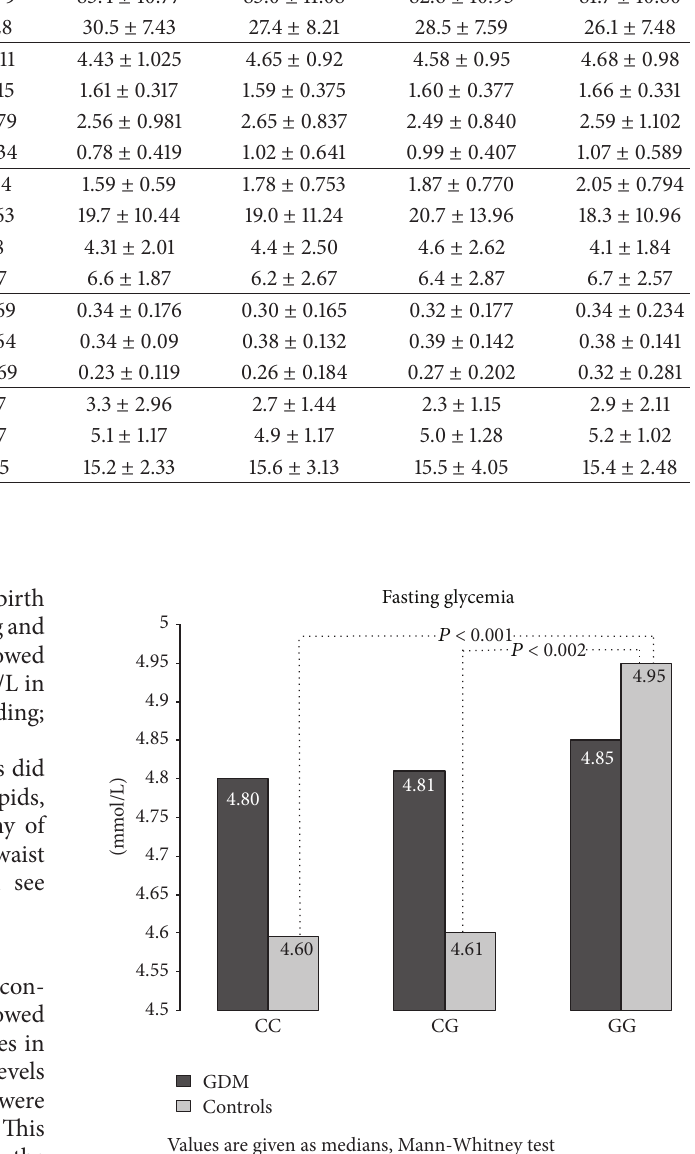
69.2 ± 17.72 , resp.; 𝑃 = 0.02 ), as well as HOMAF index ( 184.8 ± 540.60 versus 122.6 ± 124.07 , resp.; 𝑃 = 0.05